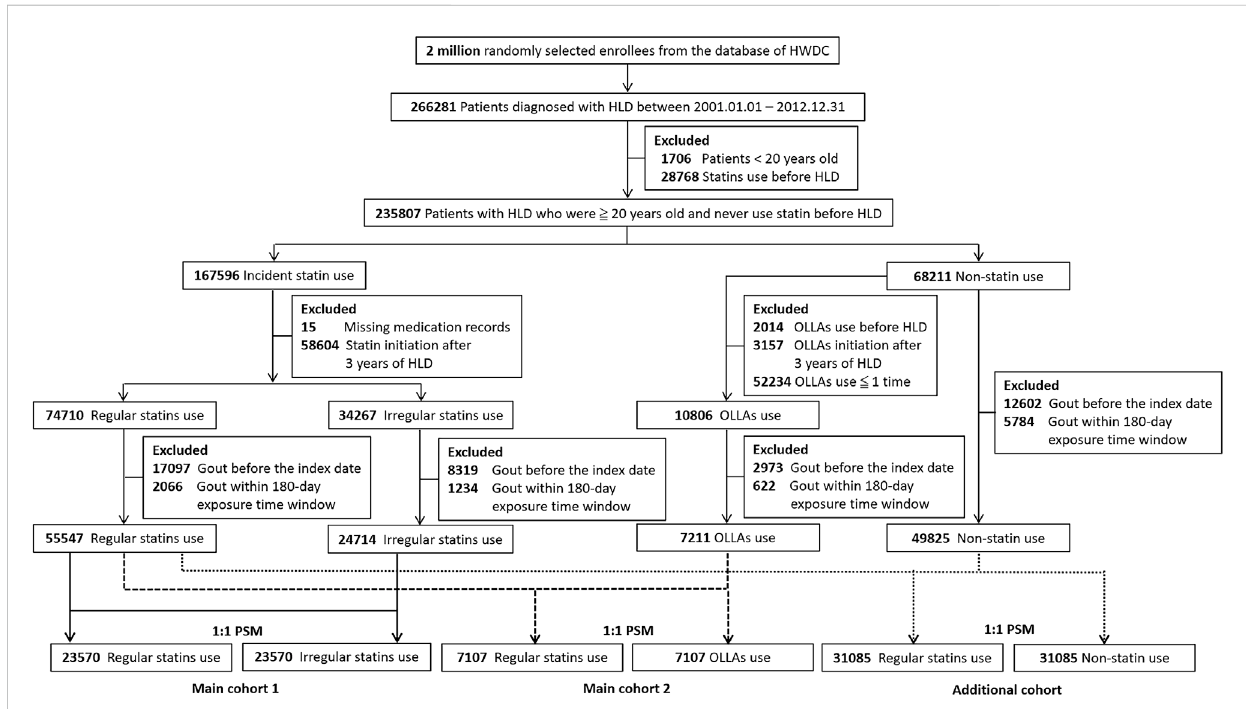
FIGURE 1 Flowchart of the enrollment of the study cohort. HWDC, Health and Welfare Data Science Center; HLD, hyperlipidemia; OLLA, other lipid-lowering agent; PSM, propensity score